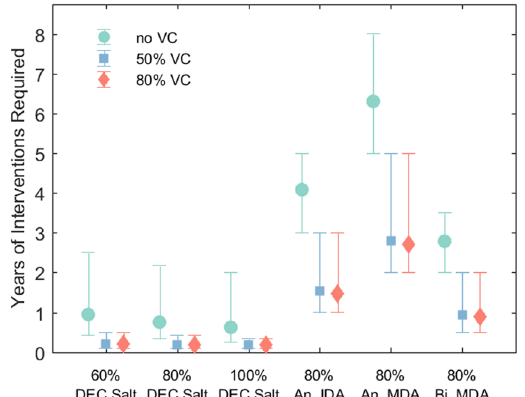
Figure 4. Number of years of alternative interventions required to reach site-specific 95% EP thresholds from 1% mf prevalence. Mean number of rounds across all study sites are shown as markers with 5 th and 95 th percentile error bars for each drug regimen and VC combination